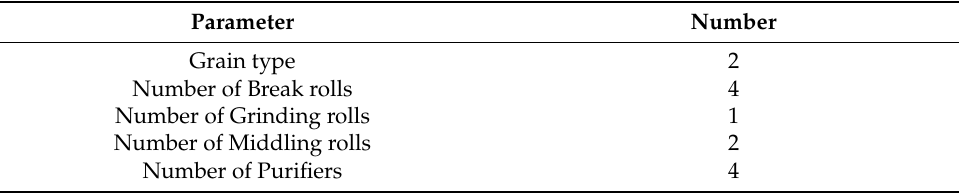
Table 1. Summary of pilot-scale roller milling parameters or unit operations.